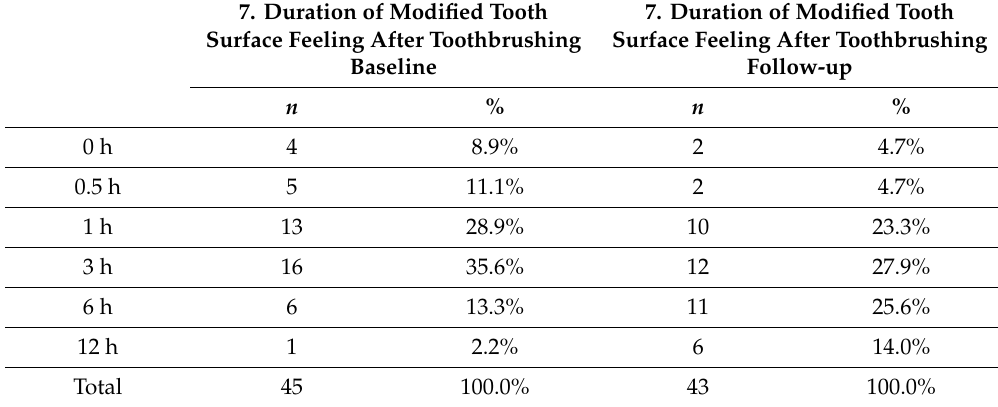
Table 6. Duration of modified tooth surface feeling (tooth smoothness after toothbrushing) at baseline and at follow-up (after 4-week use of HAP toothpaste). 7. Duration of Modified